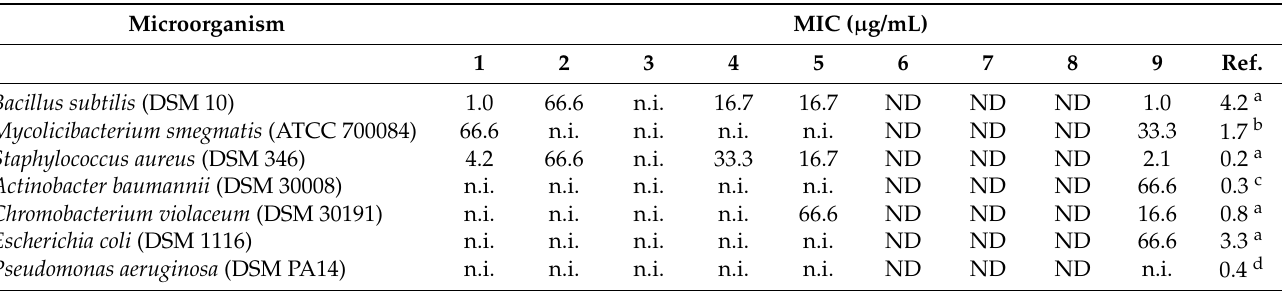
Table 4. Antibacterial activities of compounds 1 – 9 .